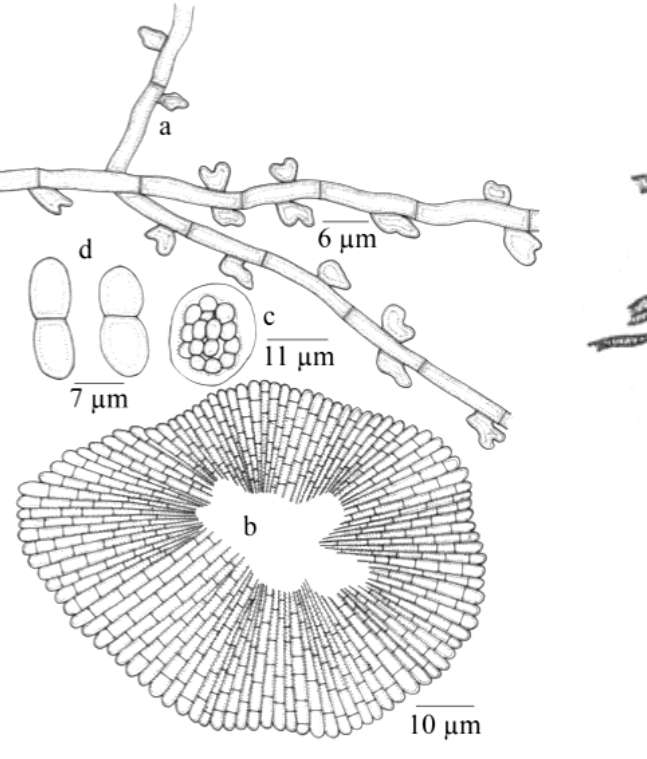
Figure 134. Asterina cipadessae a- Appressorium; b - Thyriothecium; c - Ascus; d - Ascospores